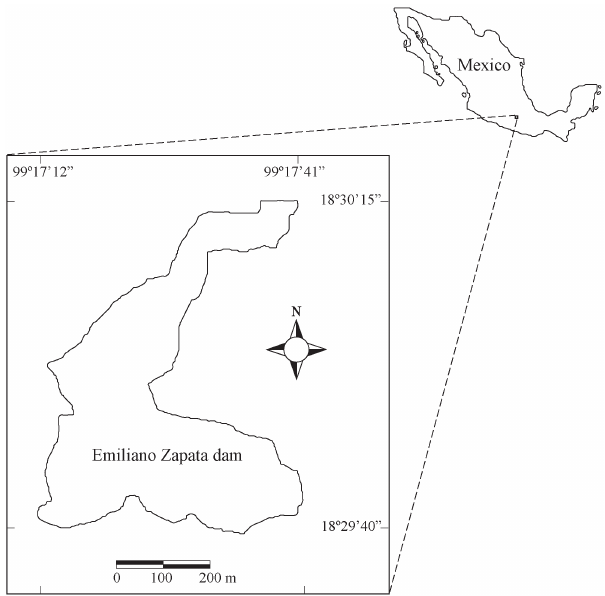
Fig. 1. Map showing location of the study area in Mexico where Poecilia sphenops samples were